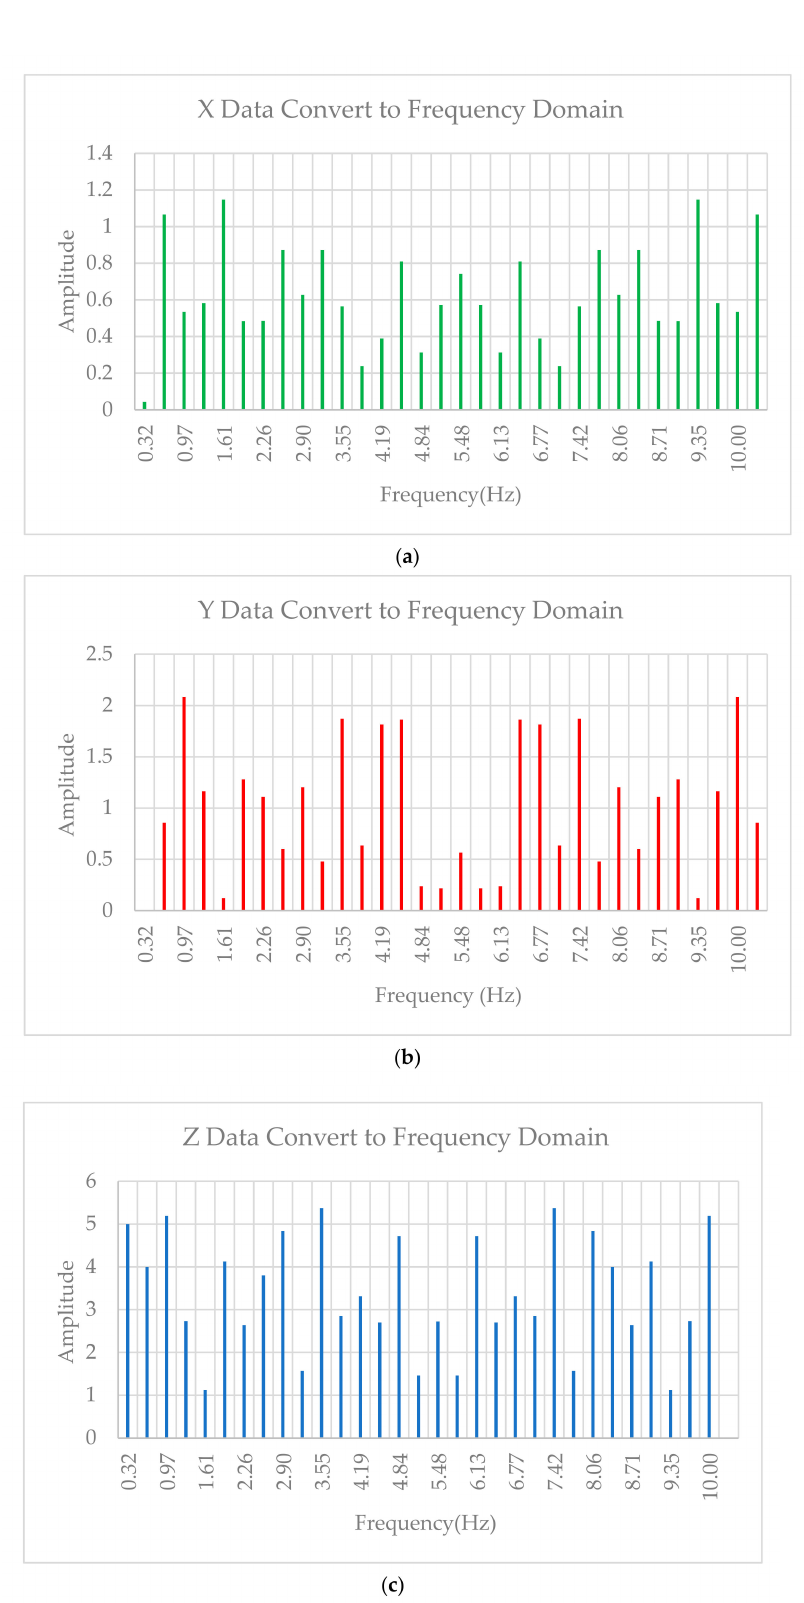
Figure 13. ( a ): X Data convert from Time Domain to Frequency; ( b ): Y Data convert from Time Domain to Frequency; ( c ): Z Data convert from Time Domain to